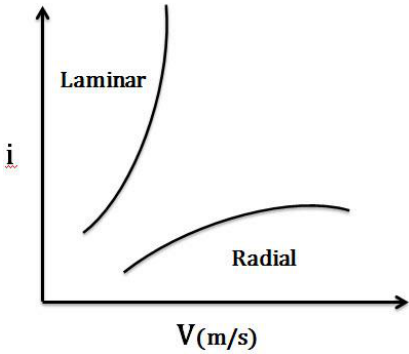
Figure 3. The schematic velocity – hydraulic gradient (i-v) curve of the parallel and radial